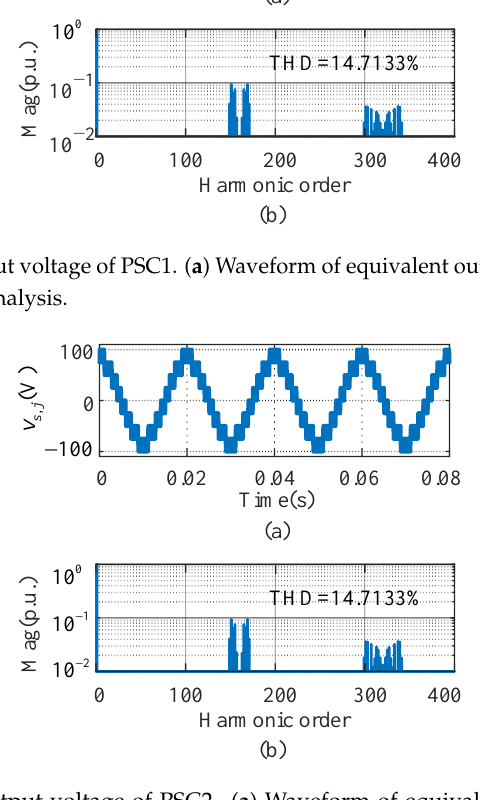
Figure 10. Theoretical output voltage of PSC2. ( a ) Waveform of equivalent output-phase voltage; ( b ) FFT analysis.